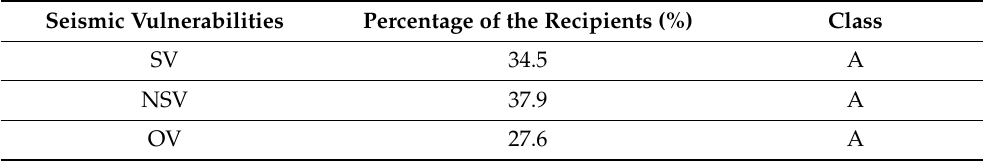
Table 3. Comparison between the seismic vulnerabilities of